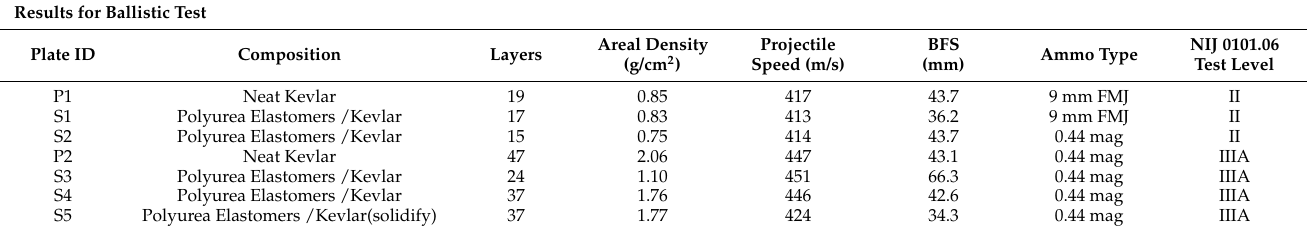
Figure 9. The dynamic back face deformation response of the 7-ply ( a ) neat Kevlar plate at t = 0 s; ( b ) neat Kevlar plate at t = 6.7 × 10 −5 s; ( c ) neat Kevlar plate at t = 1.3 × 10 −4 s; ( d ) neat Kevlar plate at t = 4.0 × 10 −4 s; ( e ) Polyurea Elastomers/Kevlar plate at t = 0 s; ( f ) Polyurea Elastomers/Kevlar plate at t = 6.7 × 10 −5 s; ( g ) Polyurea Elastomers/Kevlar plate at t = 1.3 × 10 −4 s; ( h ) Polyurea Elastomers/Kevlar plate t = 4.0 × 10 −4 s. Table 1. The ballistic test results of Polyurea Elastomers/Kevlar plates with the NIJ-standard 0101.06 Type II and Type